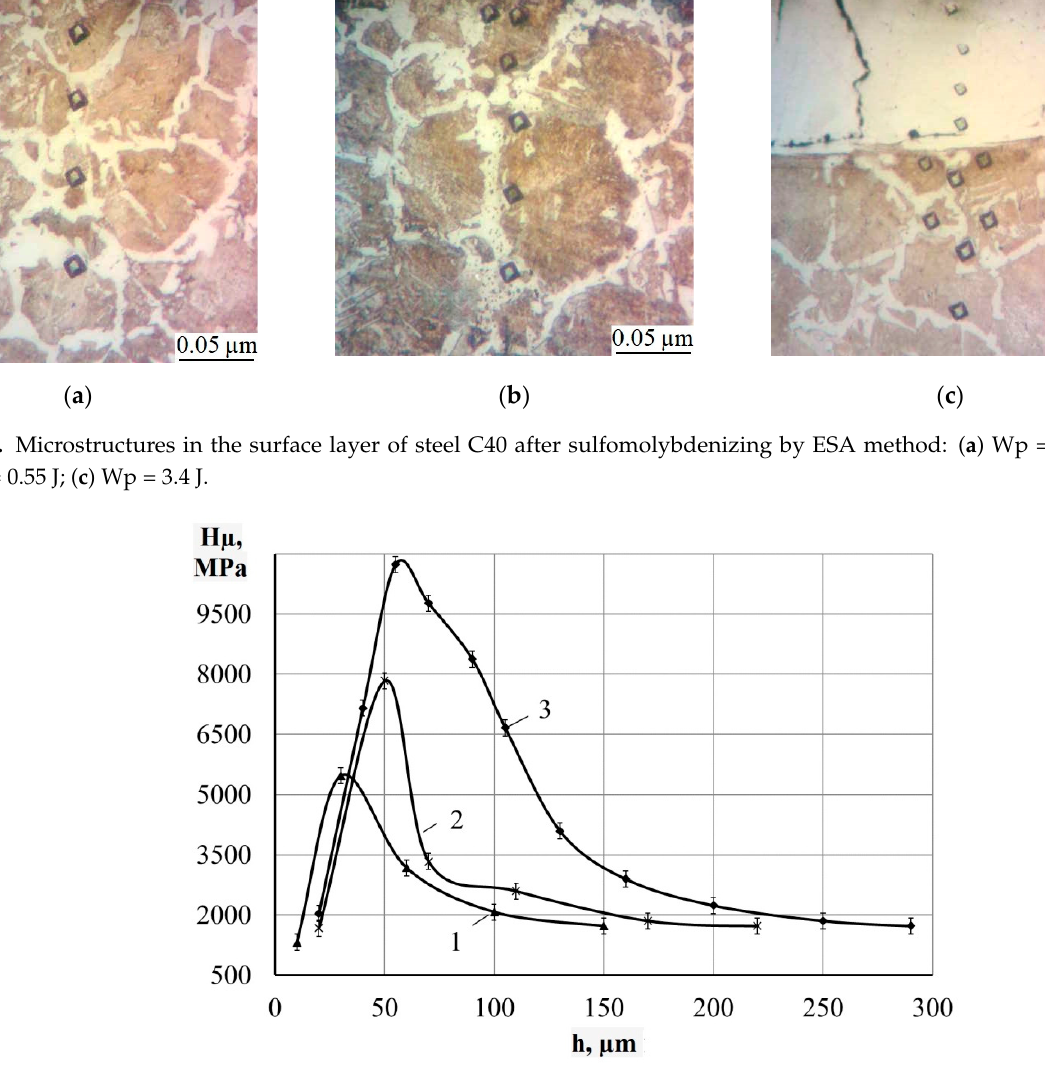
Figure 5. Distribution of microhardness in the surface layer of steel C40 after sulfomolybdenizing by